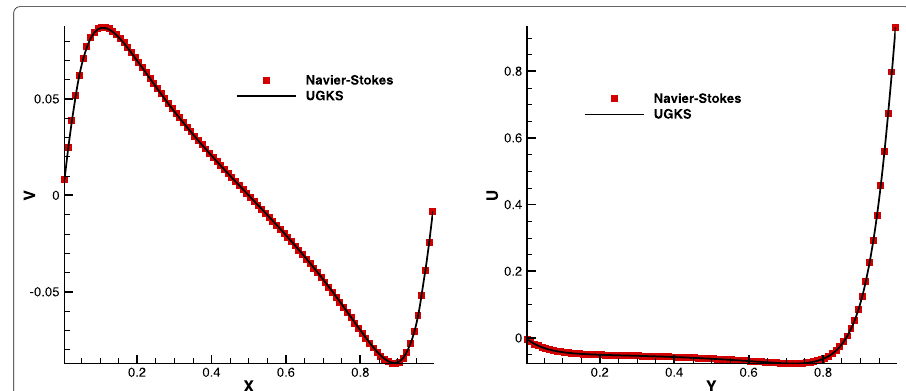
Fig. 21 The velocity distribution of the lid-driven cavity flow with Knudsen number 10 − 4 . Left figure shows the y-directional velocity distribution along y = 0.5, and right figure shows the x-directional velocity distribution along x =